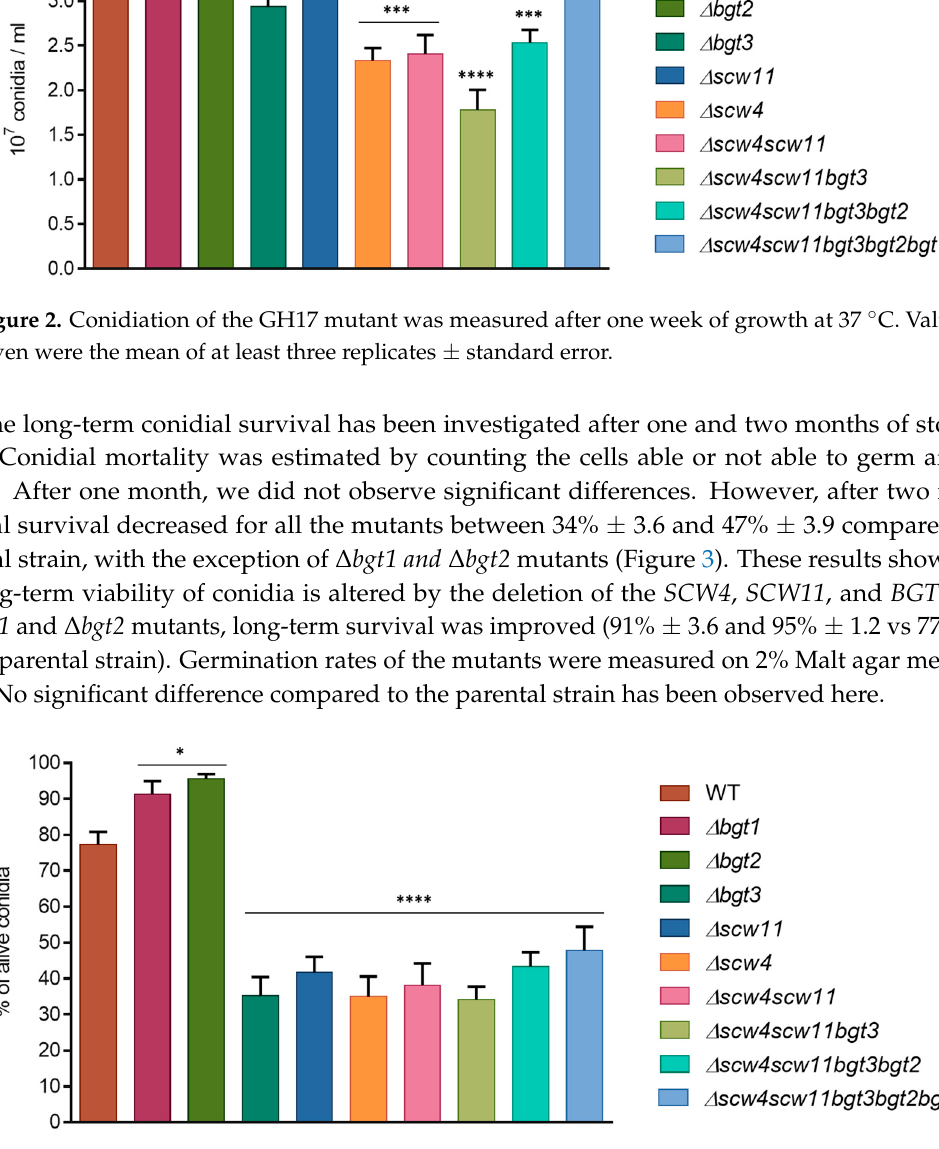
Figure 3. Conidial survival of different GH17 mutants after two months storage at 37 °C (WT: parental strain). Experiments were performed in triplicate.